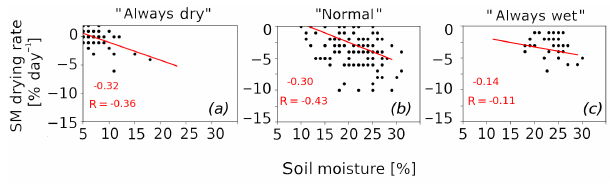
Figure A1. Examples of three possible relationships between cli- matology of soil moisture drying rate and absolute soil moisture in L min locations. The red numbers indicate values of a slope and Spearman correlation